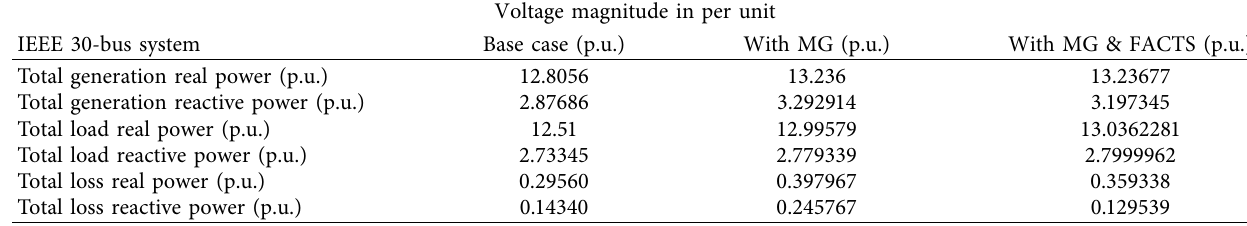
Table 3: Total generation, power consumption, and total power losses in the IEEE 30-bus test system with and without microgrid and FACTS.